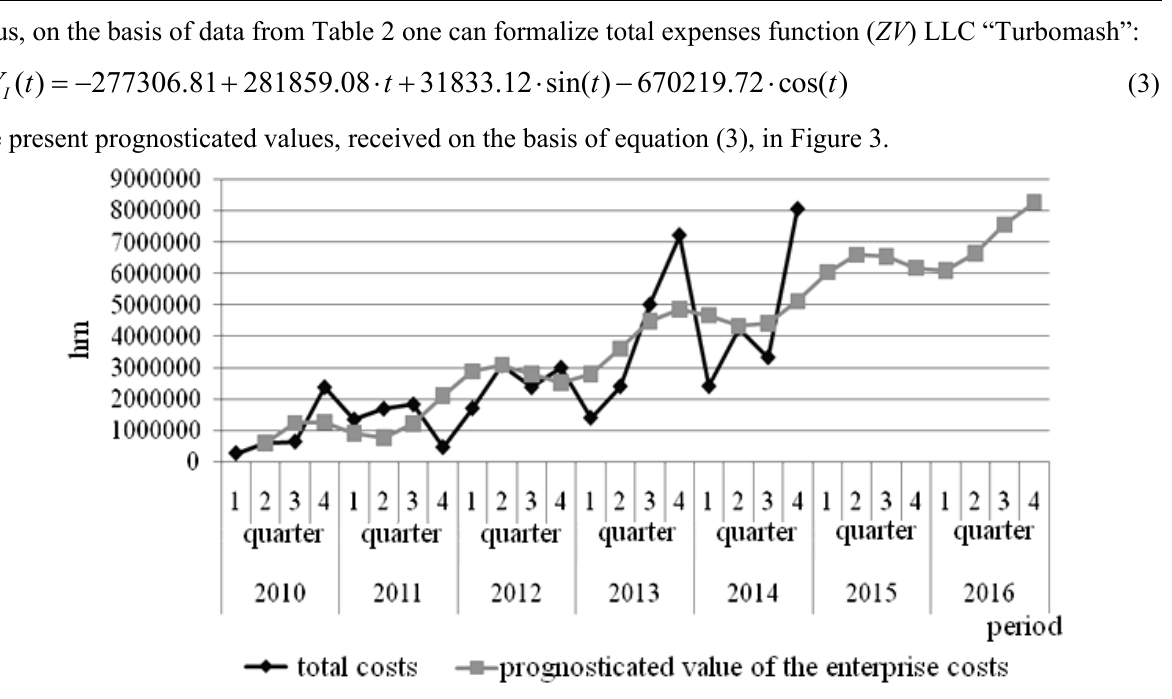
Fig. 3. Dynamics of total expenses of real and prognosticated values at LLC “Turbomash” during 2010-2016 within quarters,